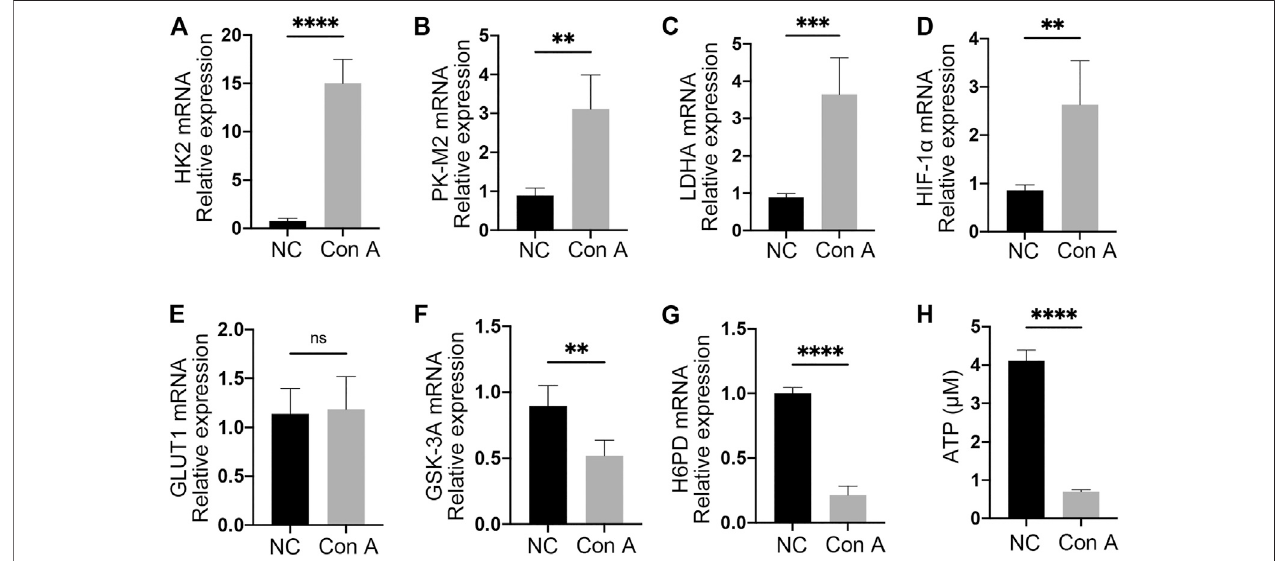
FIGURE 4 | EAH-derived Tregs had enhanced glycolysis and decreased OXPHOS. (A – C) The expression of HK2, PK-M2, and LDHA in freshly isolated Tregs from NCs and EAH model mice was assessed by RT-qPCR. (D – E) HIF-1 α and GLUT1 mRNA levels. (F – G) GSK-3A and H6PD mRNA levels. (H) Magnetically sorted Tregs from each group were cultured for 24 h. Cells were harvested and lysed to detect the ATP concentration. Gene expression was normalized to that of β